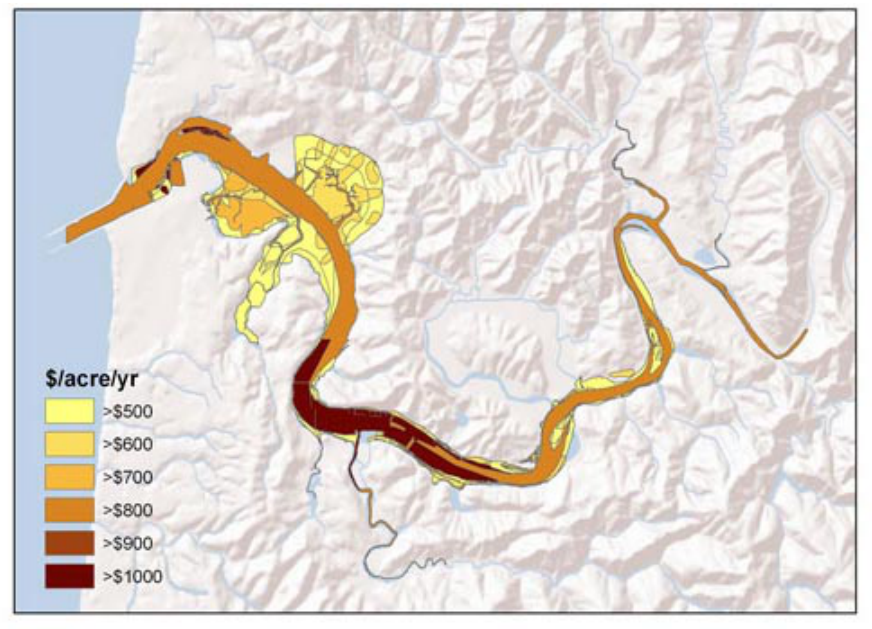
Fig. 4 . Distribution of fisheries service values in the Yaquina